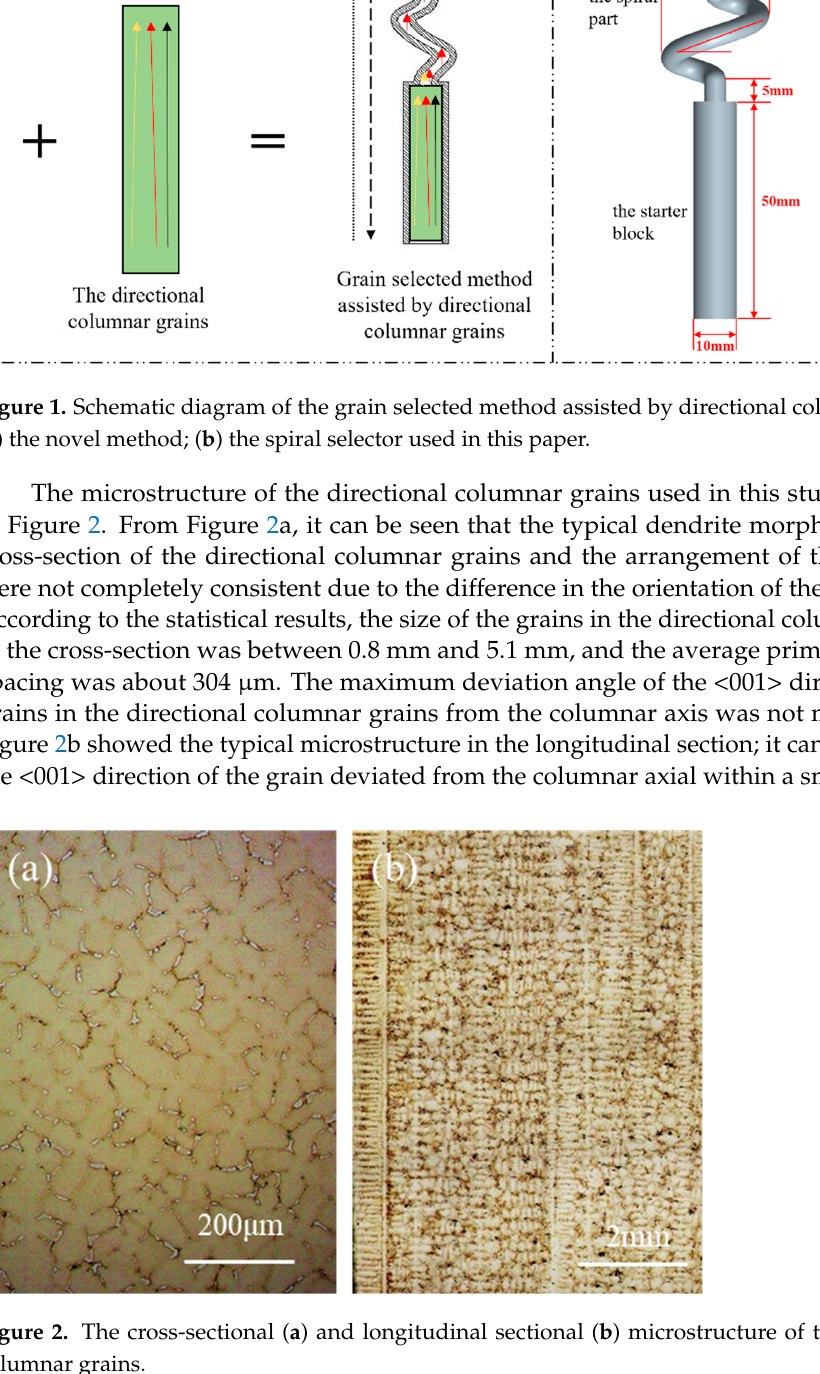
Figure 2. The cross-sectional ( a ) and longitudinal sectional ( b ) microstructure of the directional co- lumnar grains.